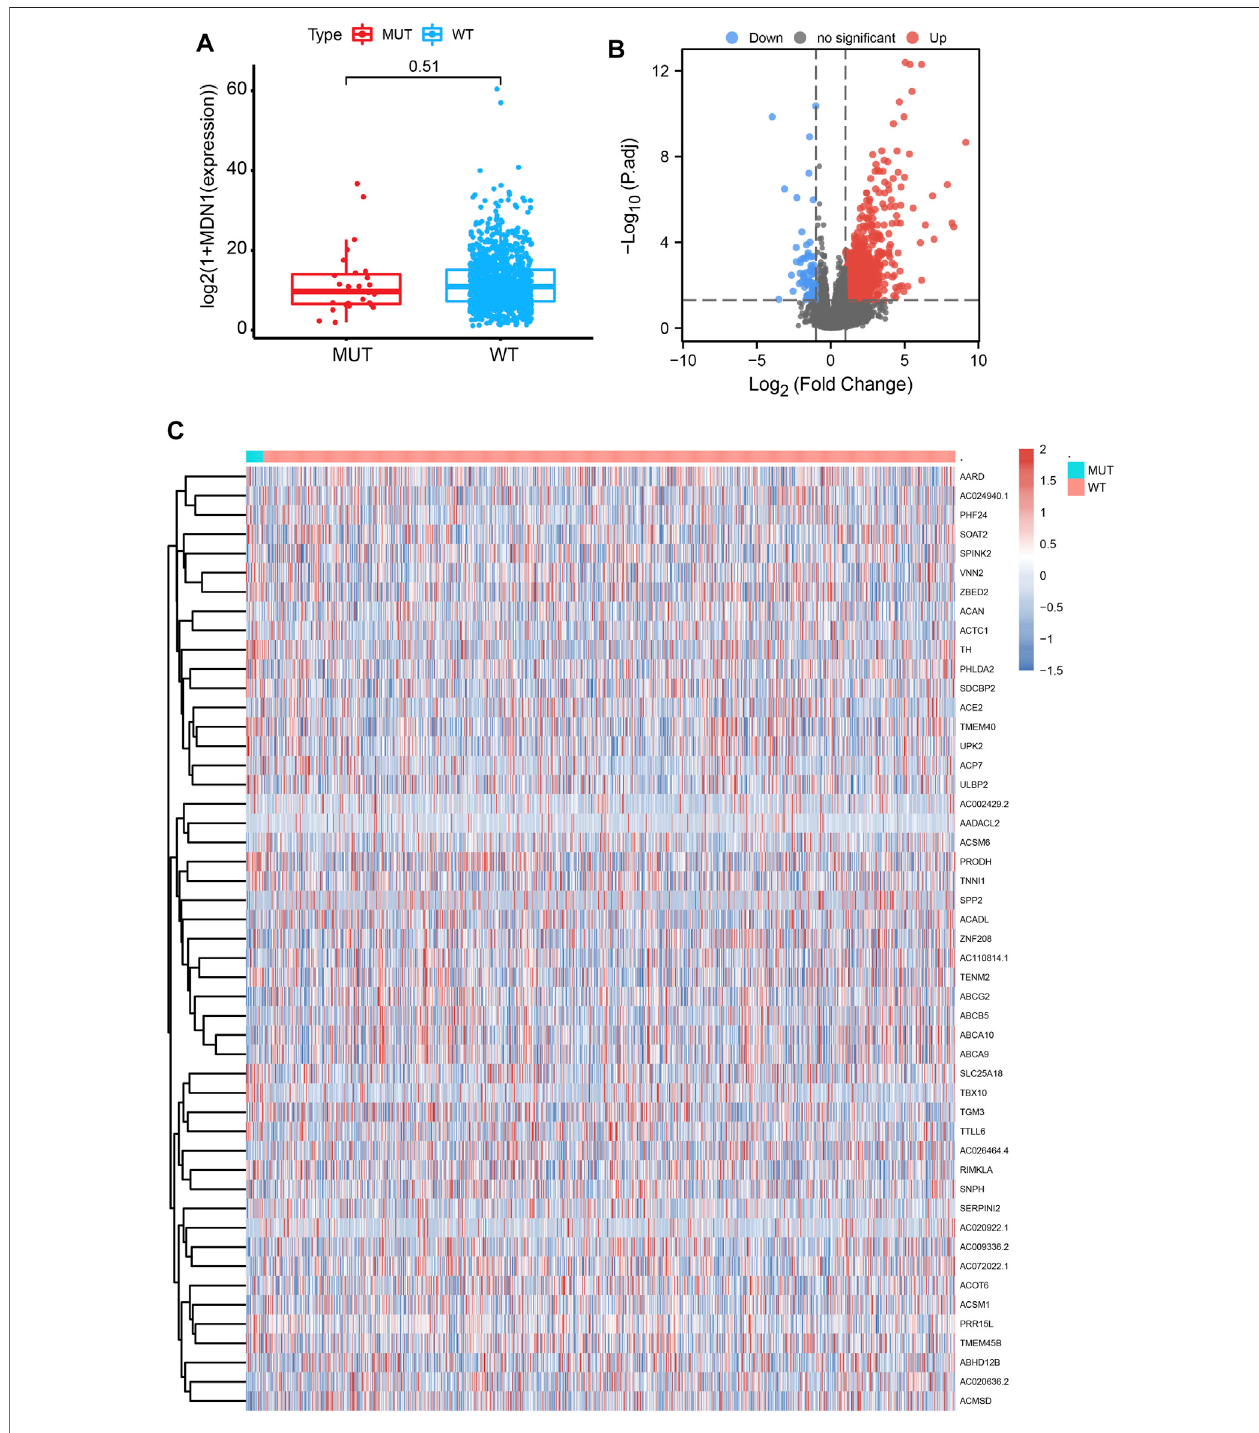
FIGURE 5 | Differentially expressed genes (DEGs) based on the mutation status of the MDN1 gene. (A) No signi fi cant difference in MDN1 expression levels was found in the MDN1 mutation group compared to the MDN1 wild-type group ( p = 0.51); (B,C) Volcano and heatmaps showing the expression of DEGs between the MDN1 mutation group and MDN1 wild-type multivariate analysis was ranked and divided into high- and low-risk groups by the median value. The prognosis patients. The risk score of each sample obtained by of patients between the high- and low-risk group was